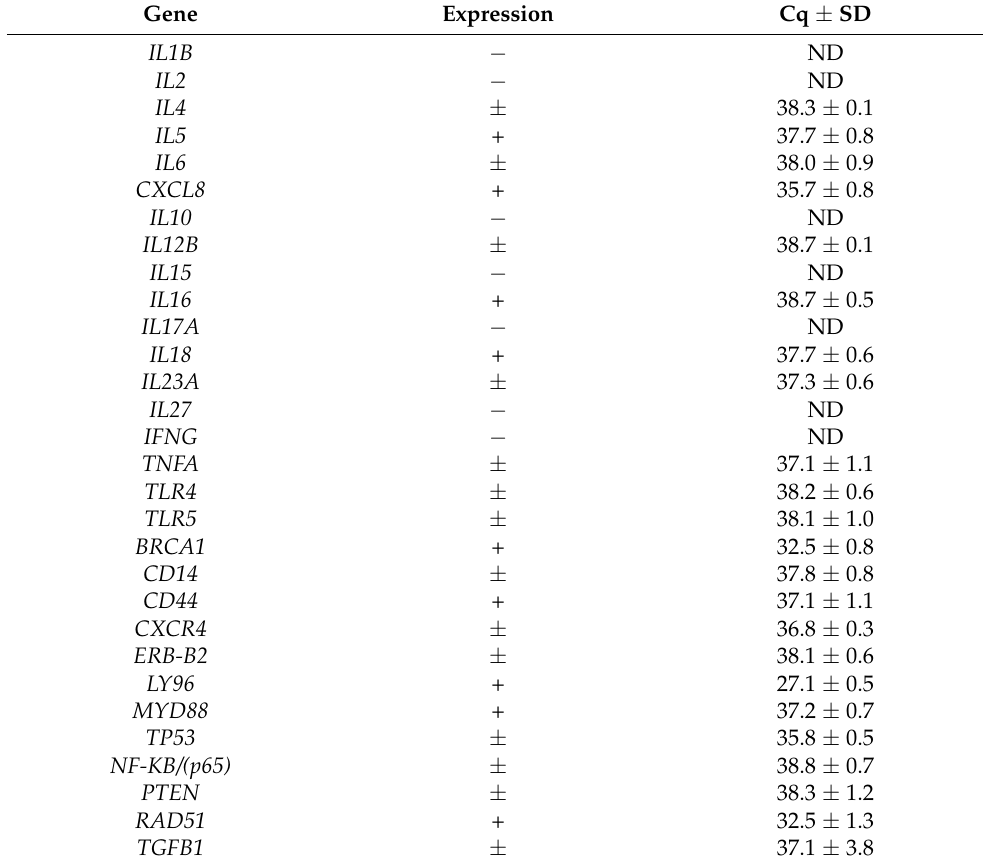
Table 5. Basal expression of inflammatory and immunomodulatory genes in CF33 cells. Data are expressed as: + all samples were positive; − all samples were negative; ± only some samples were positive. ND not